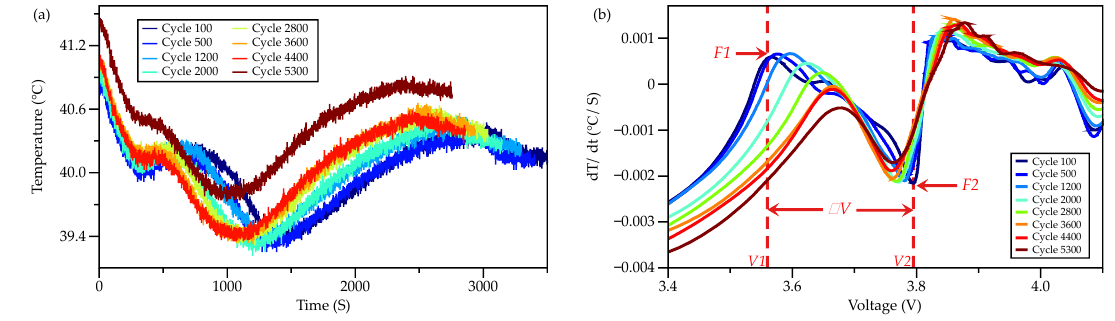
Figure 5. ( a ) Raw temperature curves of cell 1; ( b ) Smoothed DT curves of cell 1.